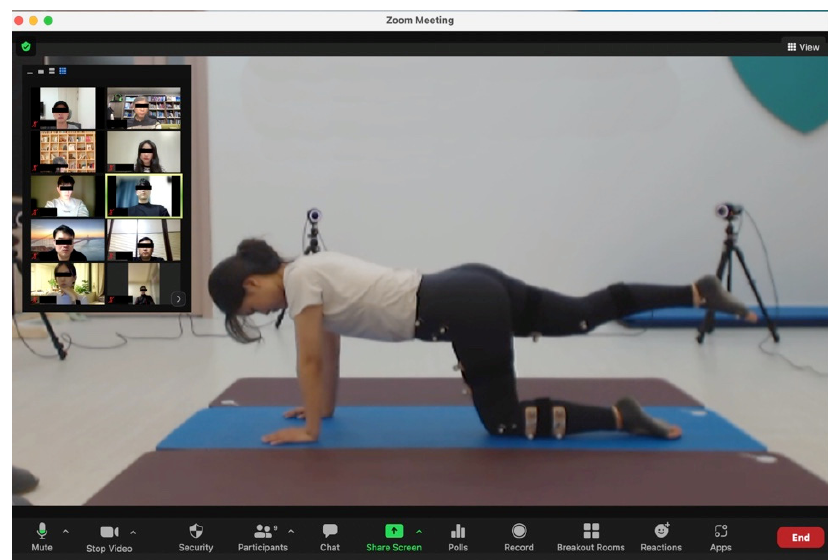
Figure 1. Video conference application for Tele-assessment.